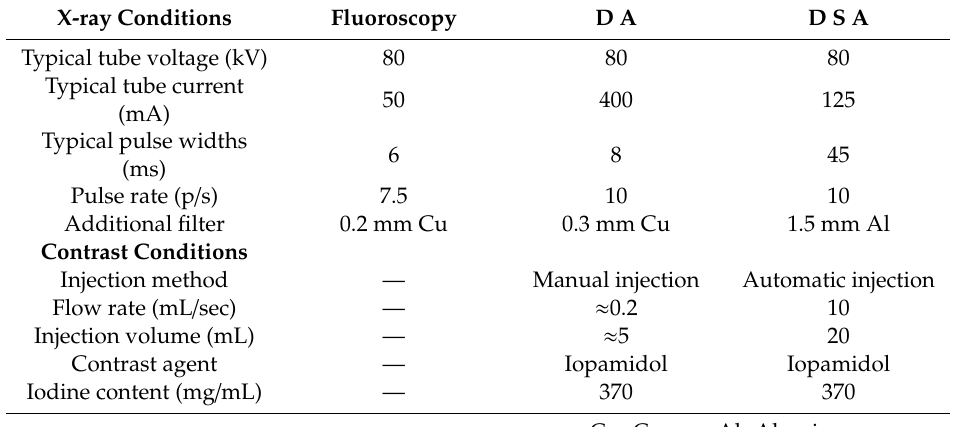
Table 1. The standard X-ray and contrast conditions used during endovascular treatment of aortic aneurysms in our hospital. X-ray Conditions